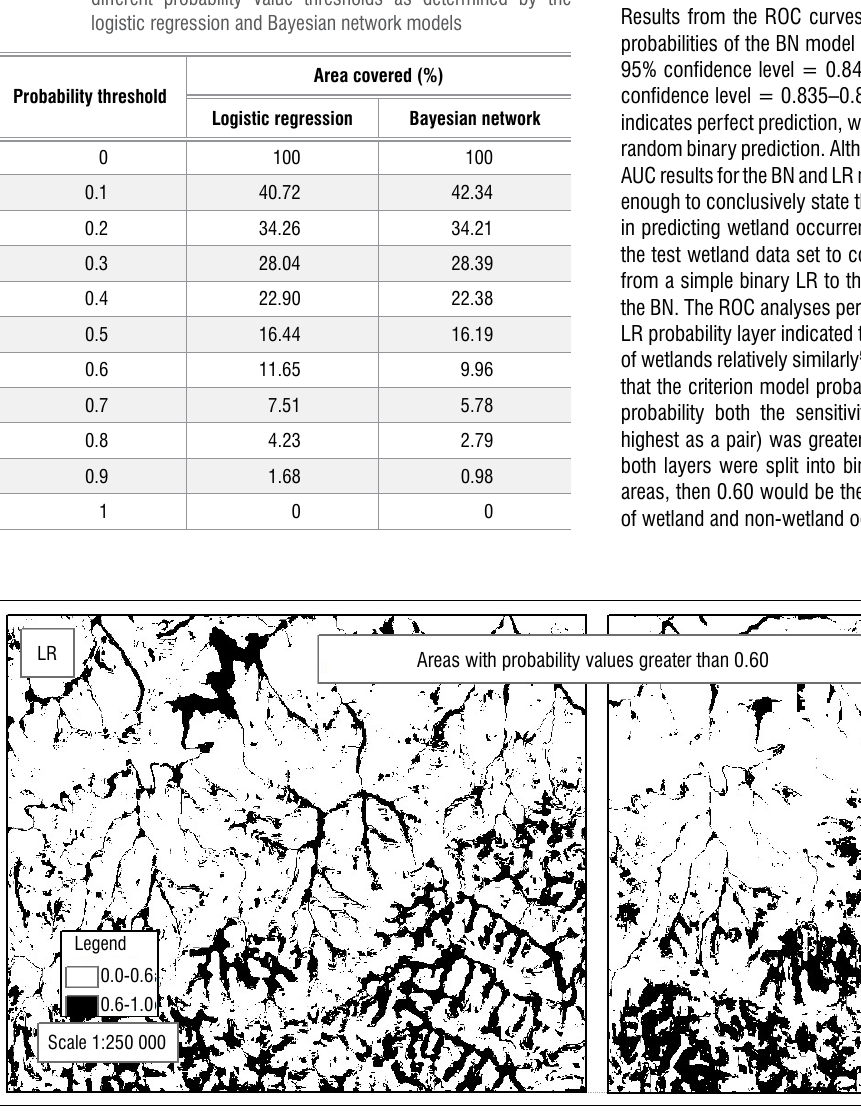
Figure 5: Comparison of likelihood of wetland occurrences for probability > 0.6 for logistic regression (LR) and Bayesian network (BN) models.